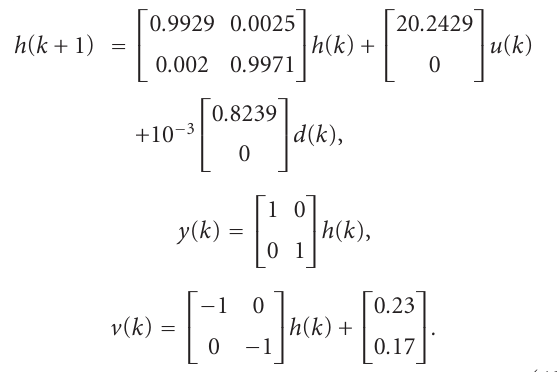
Table 1: Parameters of the tanks